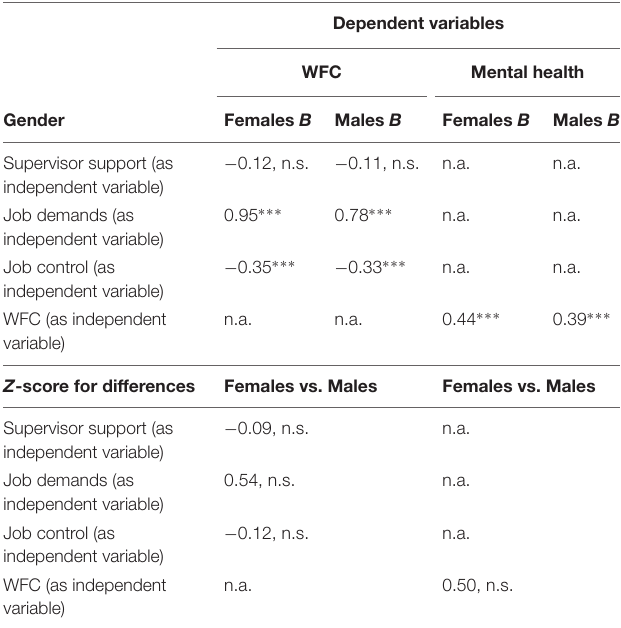
TABLE 3 | Unstandardized coefficients for the baseline model ( n = 254) and Z -scores for differences for gender. Dependent